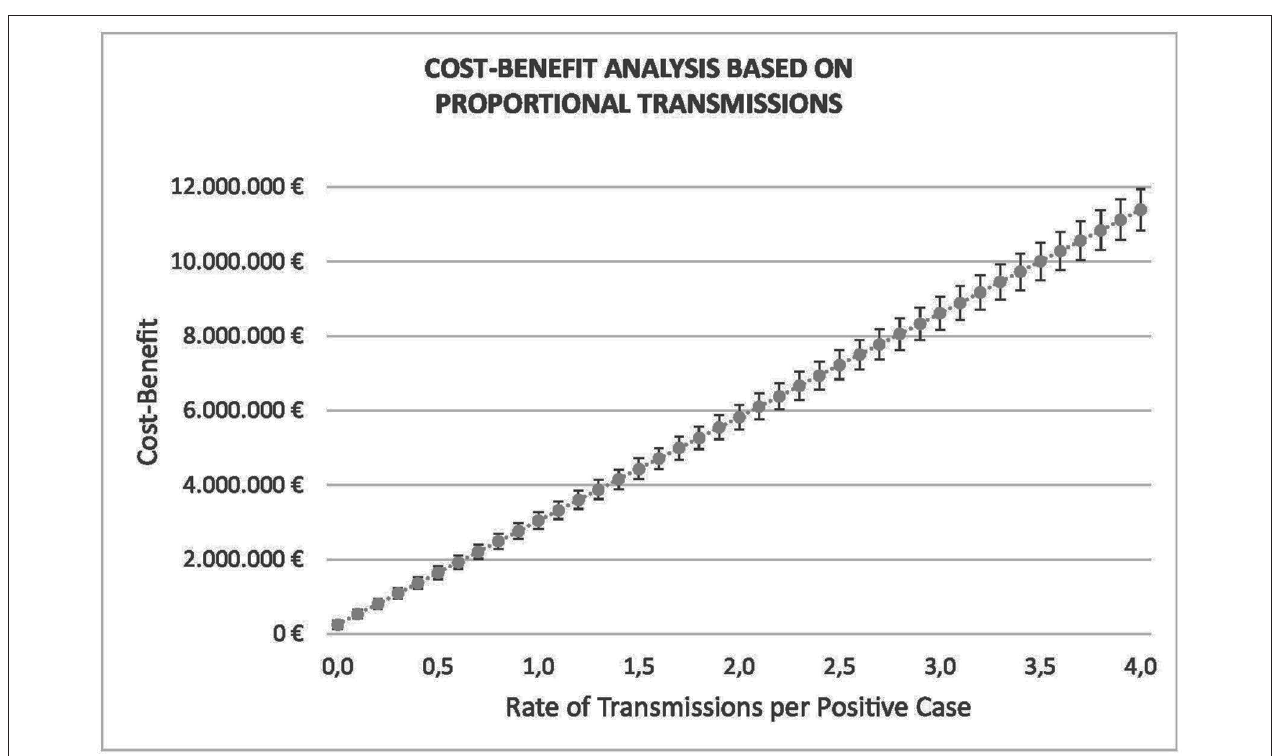
FIGURE 6 | Evolution of the savings when the transmission rate is between 0 and 4, i.e., when every infected traveler transmits the virus to no one else or up to four persons on average. Proportional rate of transmissions is